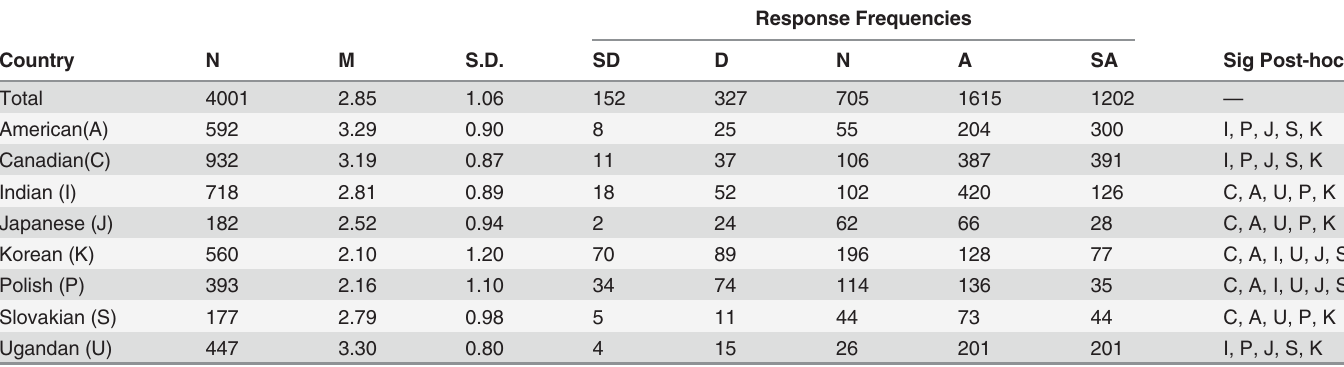
Table 2. Descriptive and Frequency Statistics for ESI-R Item 31 Concerning Perception of Test as a Measure of Spirituality.